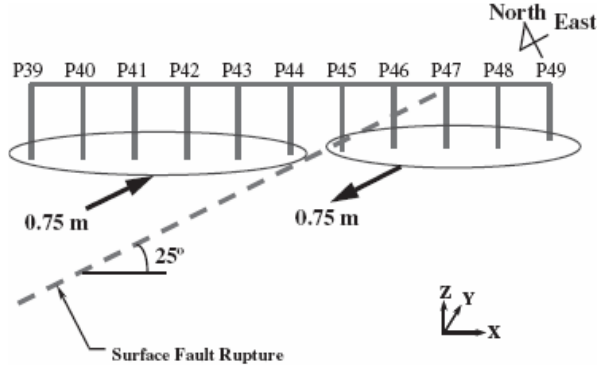
Fig. 6. Orientation of the surface fault rupture and the direction of Figure 6: Orientation of the surface fault rupture and the direction of static ground static ground displacement (Park et al., 2004). displacement (Park et al., 2004) The location of the viaducts in relation to the axis of the surface fault rupture is shown in Figure 6. The permanent differential ground displacement across the surface rupture was